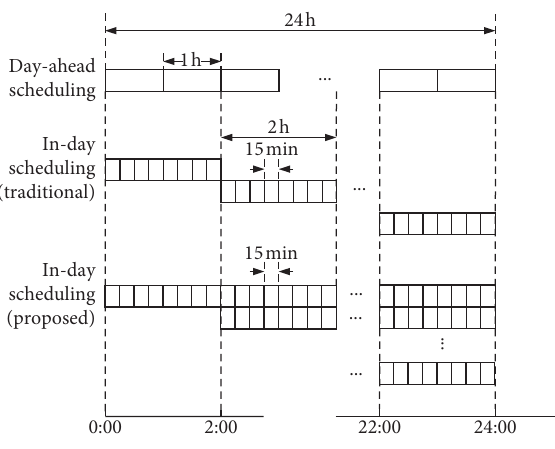
Figure 1: The framework of the rolling